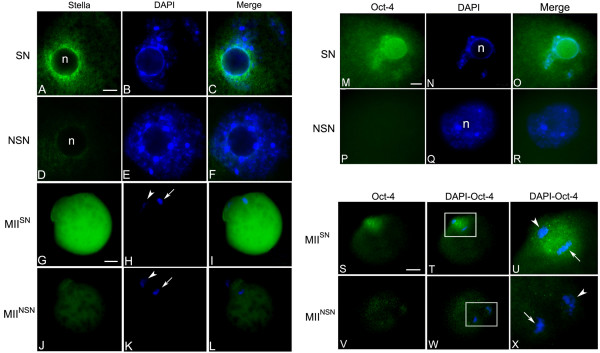
Stella and Oct-4 proteins are not detected in antral NSN and MIINSN oocytes. (A-C) An SN antral oocyte nucleus which shows the binding of the antibody against Stella (A) around its nucleolus (n); (B) the characteristic ring of DAPI-positive chromatin surrounding the nucleolus. Bar, 3 μm. (D-F) An NSN antral oocyte nucleus negative to the antibody against Stella (D); (E) the nucleus is stained with DAPI. (G-I) A MIISN oocyte that shows the binding of the antibody against Stella dispersed within the whole cytoplasm (G). Bar, 20 μm. (J-L) A MIINSN oocyte negative to the antibody against Stella (J); (H, K) the arrow indicates the MII-plate, the arrowhead indicates the first polar body. (M-O) An SN antral oocyte nucleus that shows the binding of the antibody against Oct-4 localised mainly around the nucleolus. Bar, 3 μm. (P-R) An NSN antral oocyte nucleus negative to the antibody against Oct-4 (P). (S-U) A MIISN oocyte that shows the binding of the antibody against Oct-4 localised around the MII-plate; (U) an enlargement of the insert shown in T. The arrow indicates the MII-plate, the arrowhead indicates the first polar body. Bar, 20 μm. (V-X) A MIINSN oocyte negative to the antibody against Oct-4; (X) an enlargement of the insert shown in W.